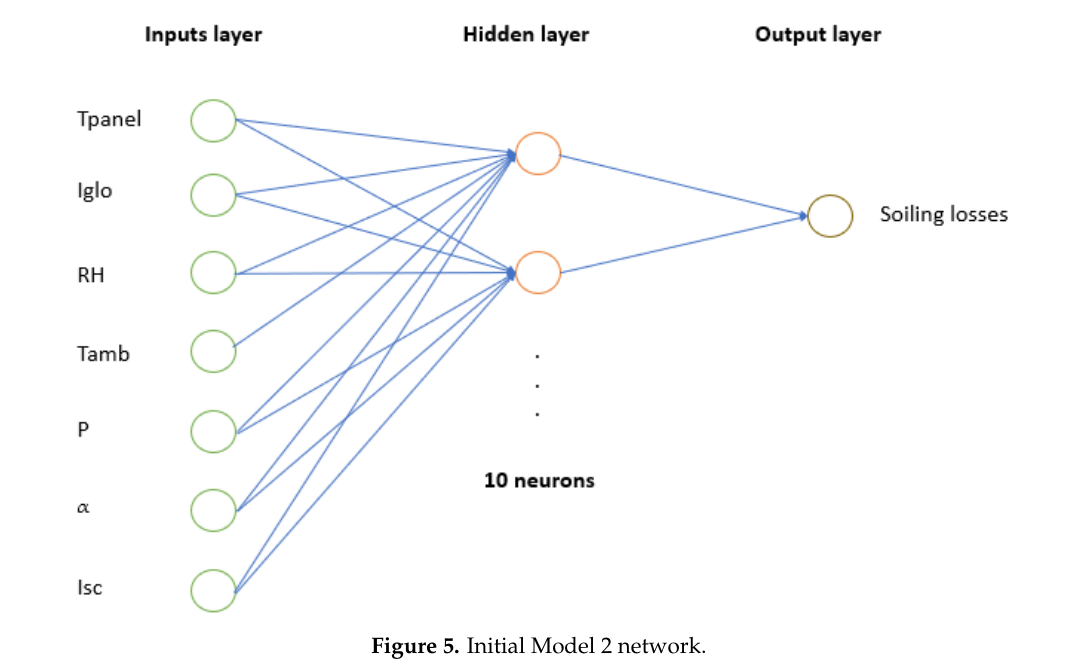
Figure 4. Final Model 1 network.